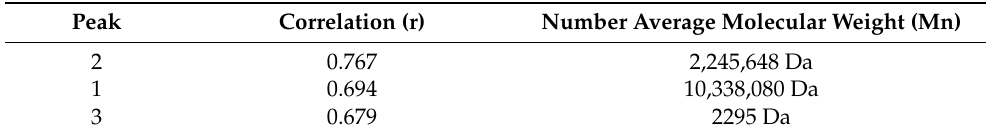
Table 2. Correlation between HPSEC fingerprints and anti-allergic activity of SPs. Peak Correlation